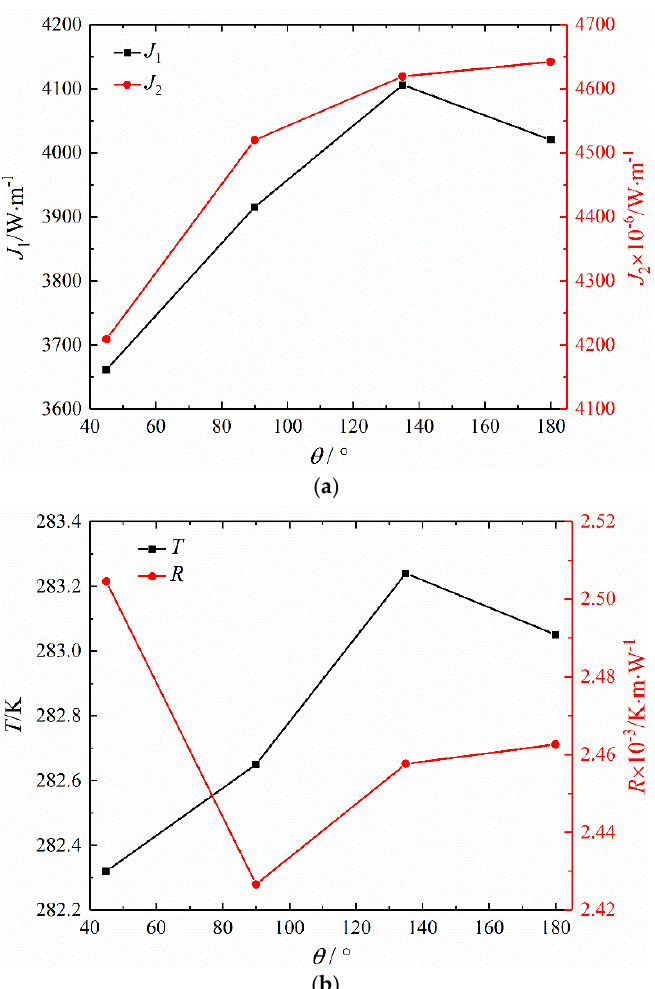
Figure 5. Variation of performance parameters under different θ values. ( a ) The heat exchange J 1 and the flow energy consumption J 2, and ( b ) The average outlet temperature T and the thermal resistance R .